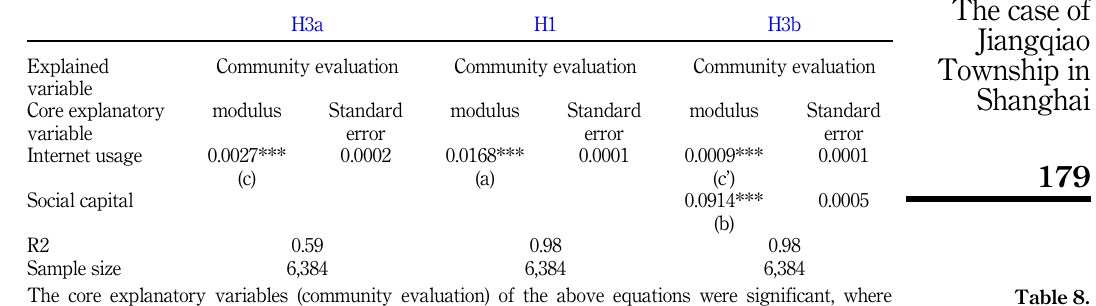
Table 8. Mediation effect